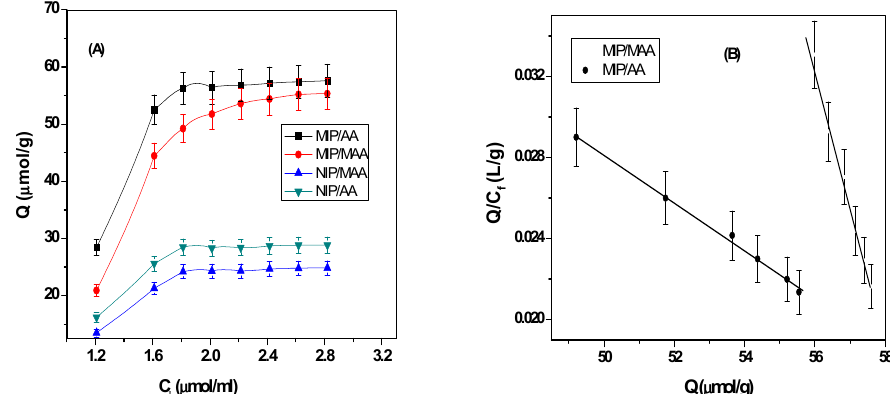
Figure 3. Scatchard analysis for the orcinol-imprinted polymers. Note: Q is the amount of orcinol bound to 20 mg of the constructed polymers; T =25 °C ; V = 10 mL; binding time = 20 h.